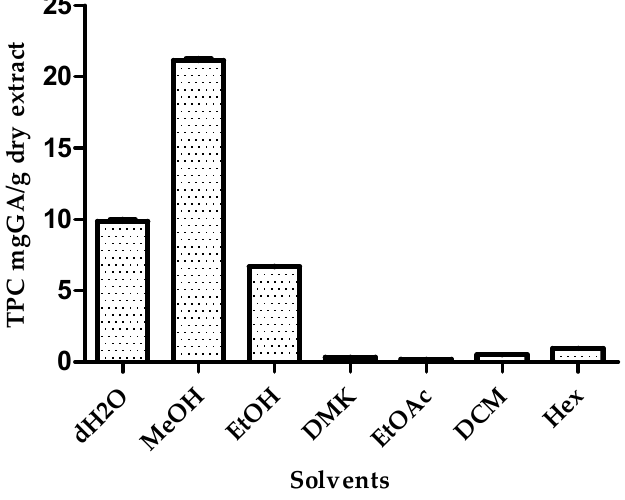
Figure 2. Effect of extraction solvents on the total phenolic content (TPC) amount. Samples of B. x buttiana extracts with solvents at 100% at 26 °C for 24 h were assayed to determine the total phenolic content, as described in the Materials and Methods section. Each bar corresponds to the results (mean ± SD) from three different preparations.